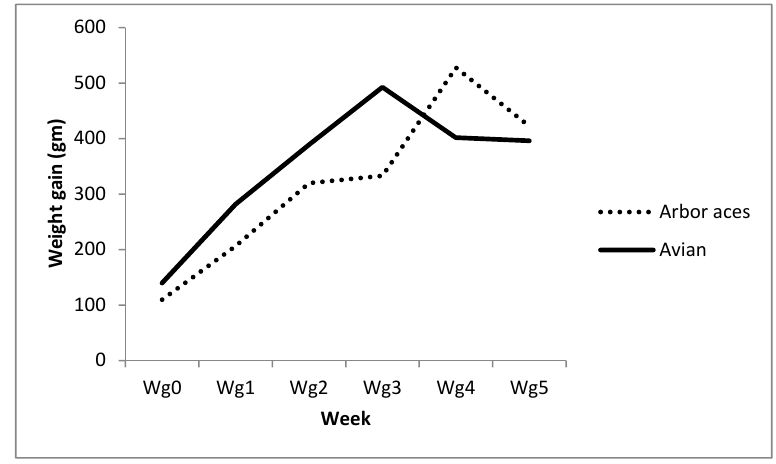
Figure 1. Weekly weight gain of Avian48 and Arbor Acres breeds.